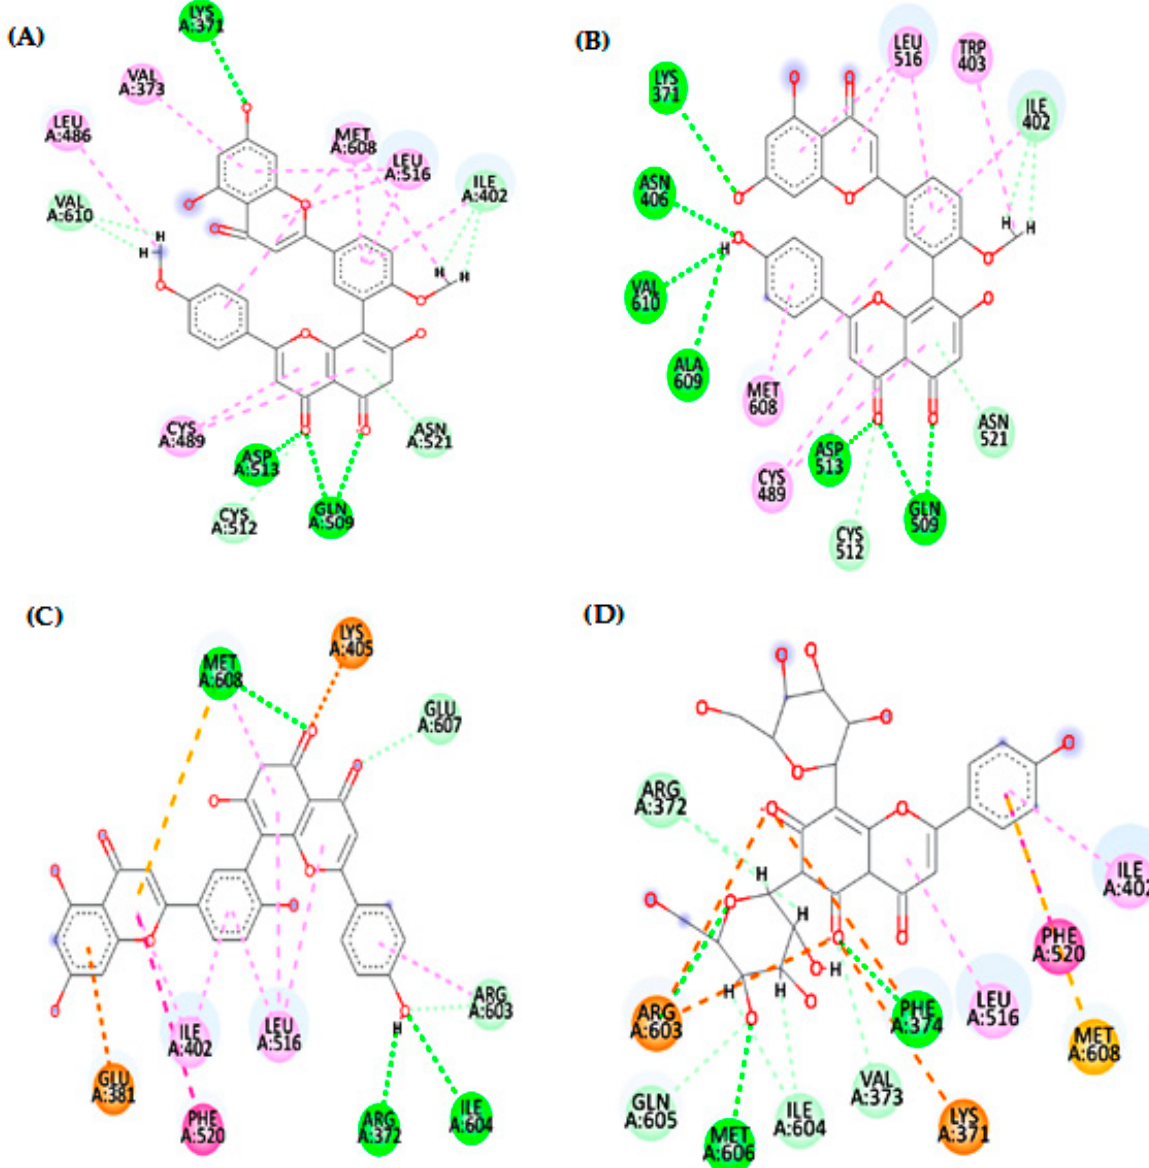
Figure 4. 2D patterns demonstrating the binding interaction of compounds 1 ( A ), 2 ( B ), 4 ( C ) and 6 ( D ) into the active site of TS-DHFR (PDB code: 4KY4); dotted pink, violet and orange lines indicate the hydrophobic interaction, and dotted green lines indicate the hydrogen bonds.